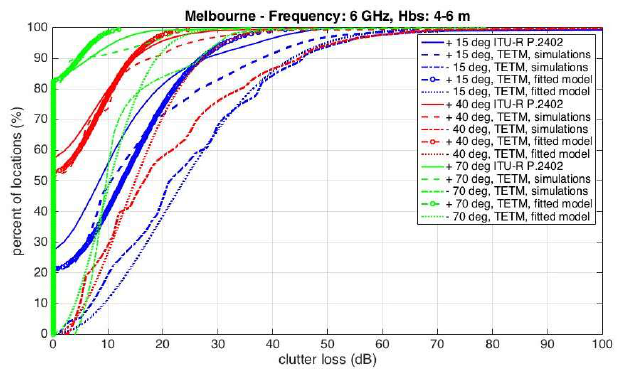
Figure 12. Clutter loss cumulative distributions: comparison between the proposed model and the ITU-R P.2402 model, for elevation angles of 15, 40 and 70 degrees in Melbourne (base station height uniformly distributed between 4 and 6 m).